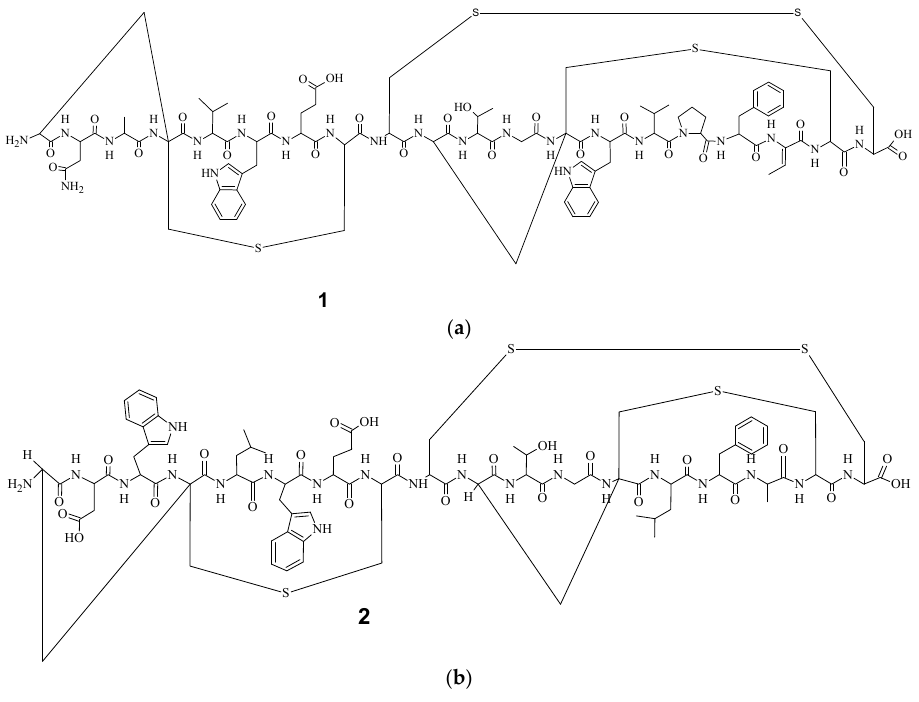
Figure 1. Chemical structures of ( a ) labyrinthopeptin A1 ( 1 ) and ( b ) labyrinthopeptin A2 ( 2 ) .